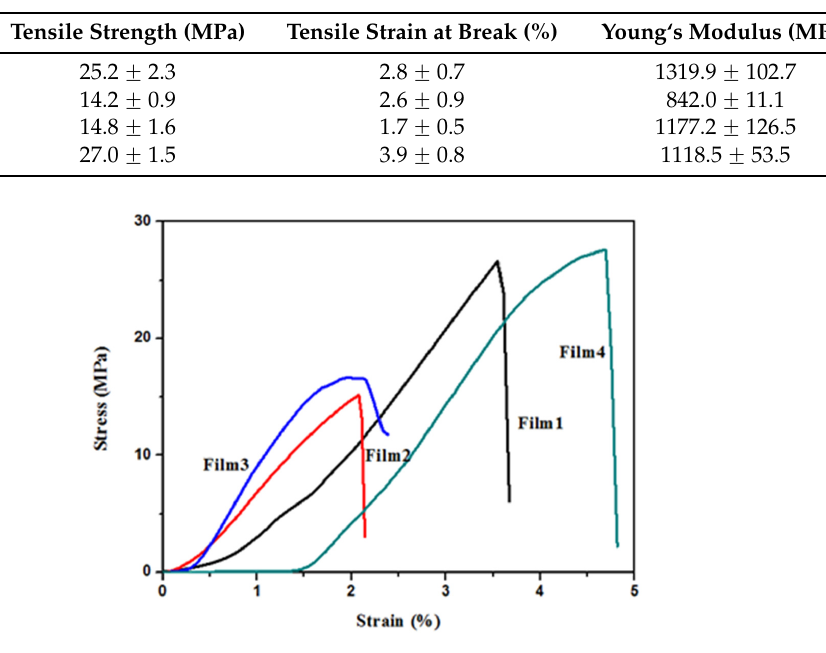
Figure 7. The tensile stress ‐ strain curves of Film 1, Film 2, Film 3, and Film 4.